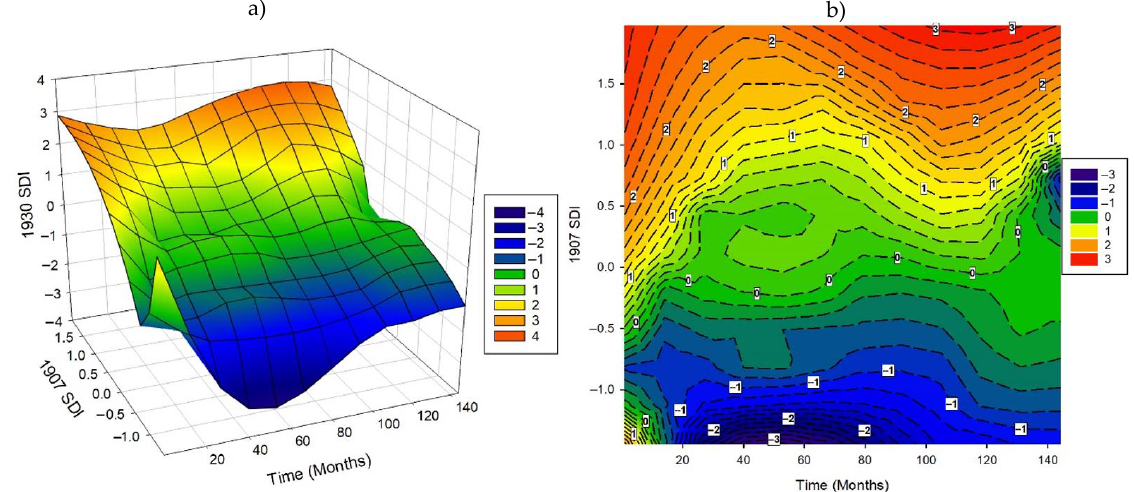
Figure 13. RMSE and MAE values for the SDI results. ( a ) RMSE results, ( b ) MAE results. Contour mappings were created between the target station SDI and the index values generated by the flow rates (Figure 14).